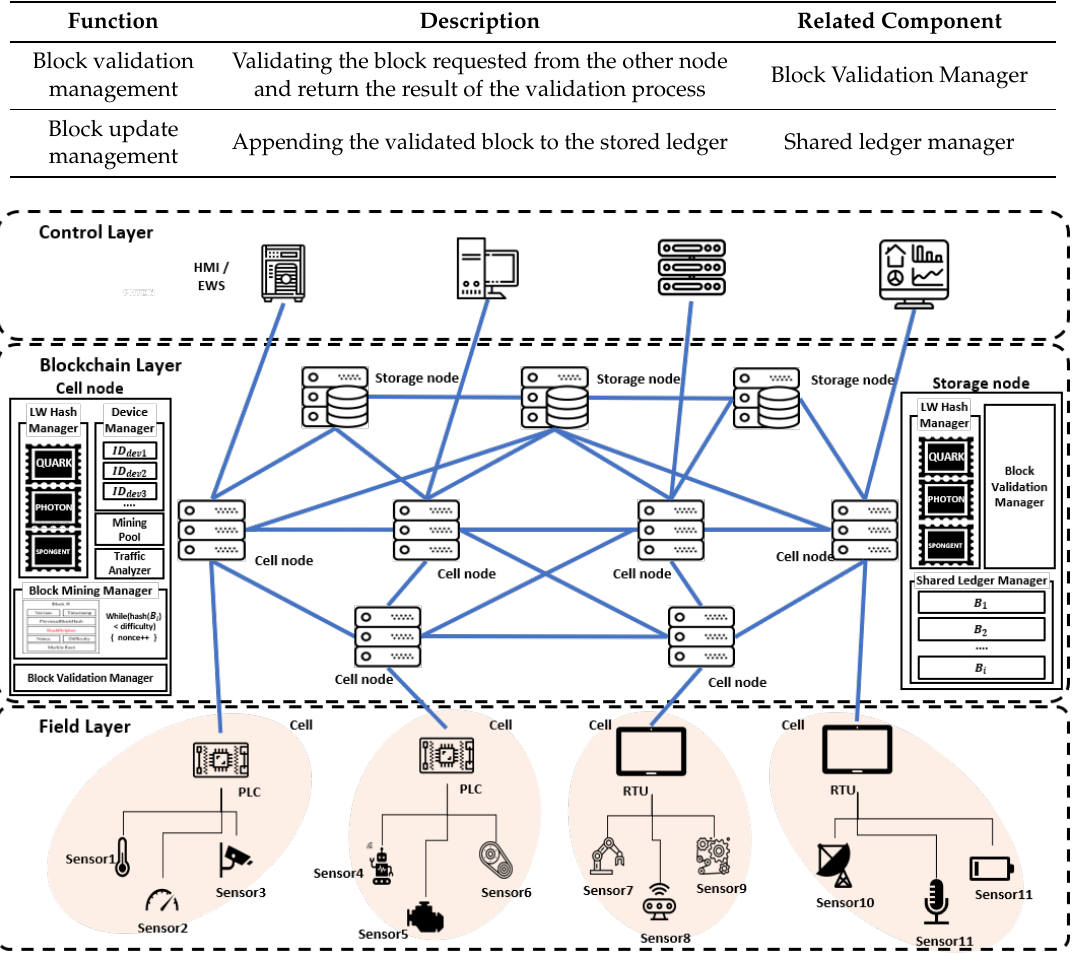
Figure 1. Overview of proposed lightweight hash-based blockchain